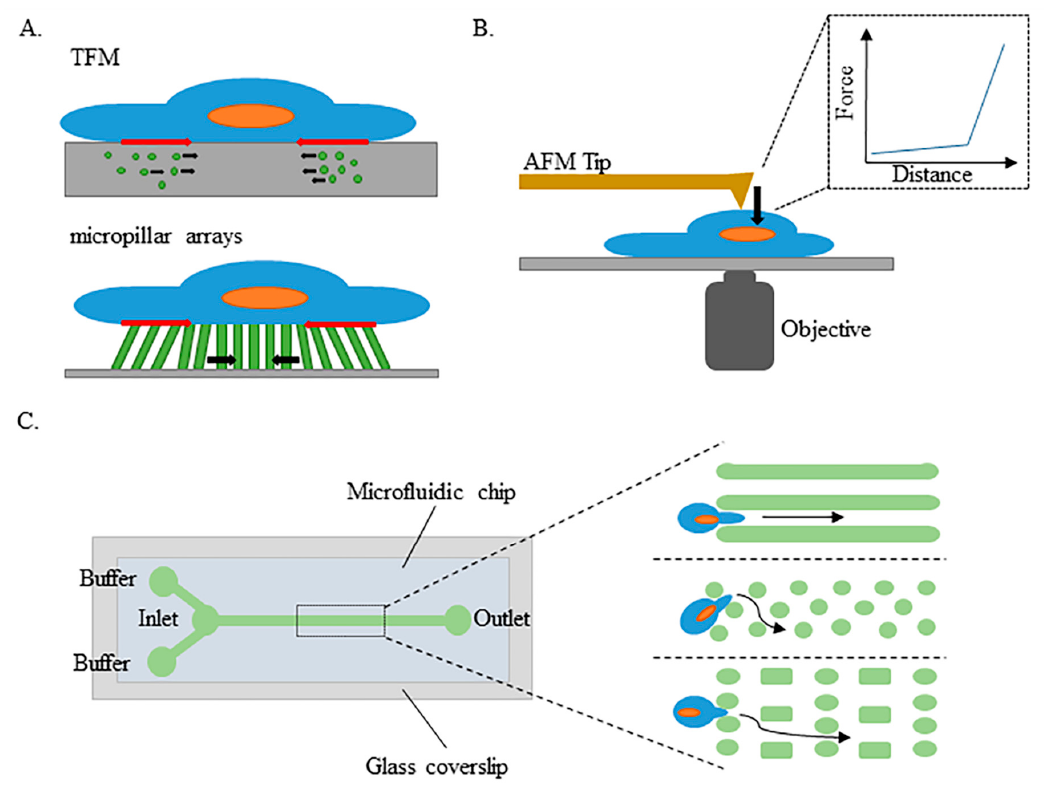
Figure 2. Schematics of four tools used to explore cellular mechanics. ( A ) Traction force microscopy (TFM) and micropillar arrays are techniques focusing on the ability of cells to apply forces and deform their environment. By following the displacement of the probes (motion of fluorescent beads (in green) in the soft substrate or deflection of fluorescent pillars), experimenters can determine the forces applied by cells to deform their substrate. ( B ) Atomic force microscopy (AFM) allows the viscoelastic properties of cells to be determined by measuring the relationship between the AFM tip displacement and the force applied to deform the cell (right part of the graphics). ( C ) Different designs of microfluidic chips allowing studies of dynamic cell deformation through small passages can be used to study the viscoelastic response of cells.